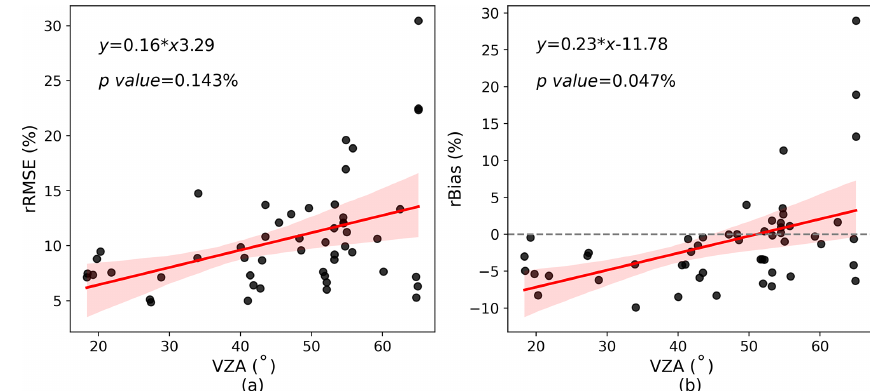
Figure 10. The impact of VZA on DSR estimation rRMSE (a) and rBias (b) . The regression equation and p value are shown.